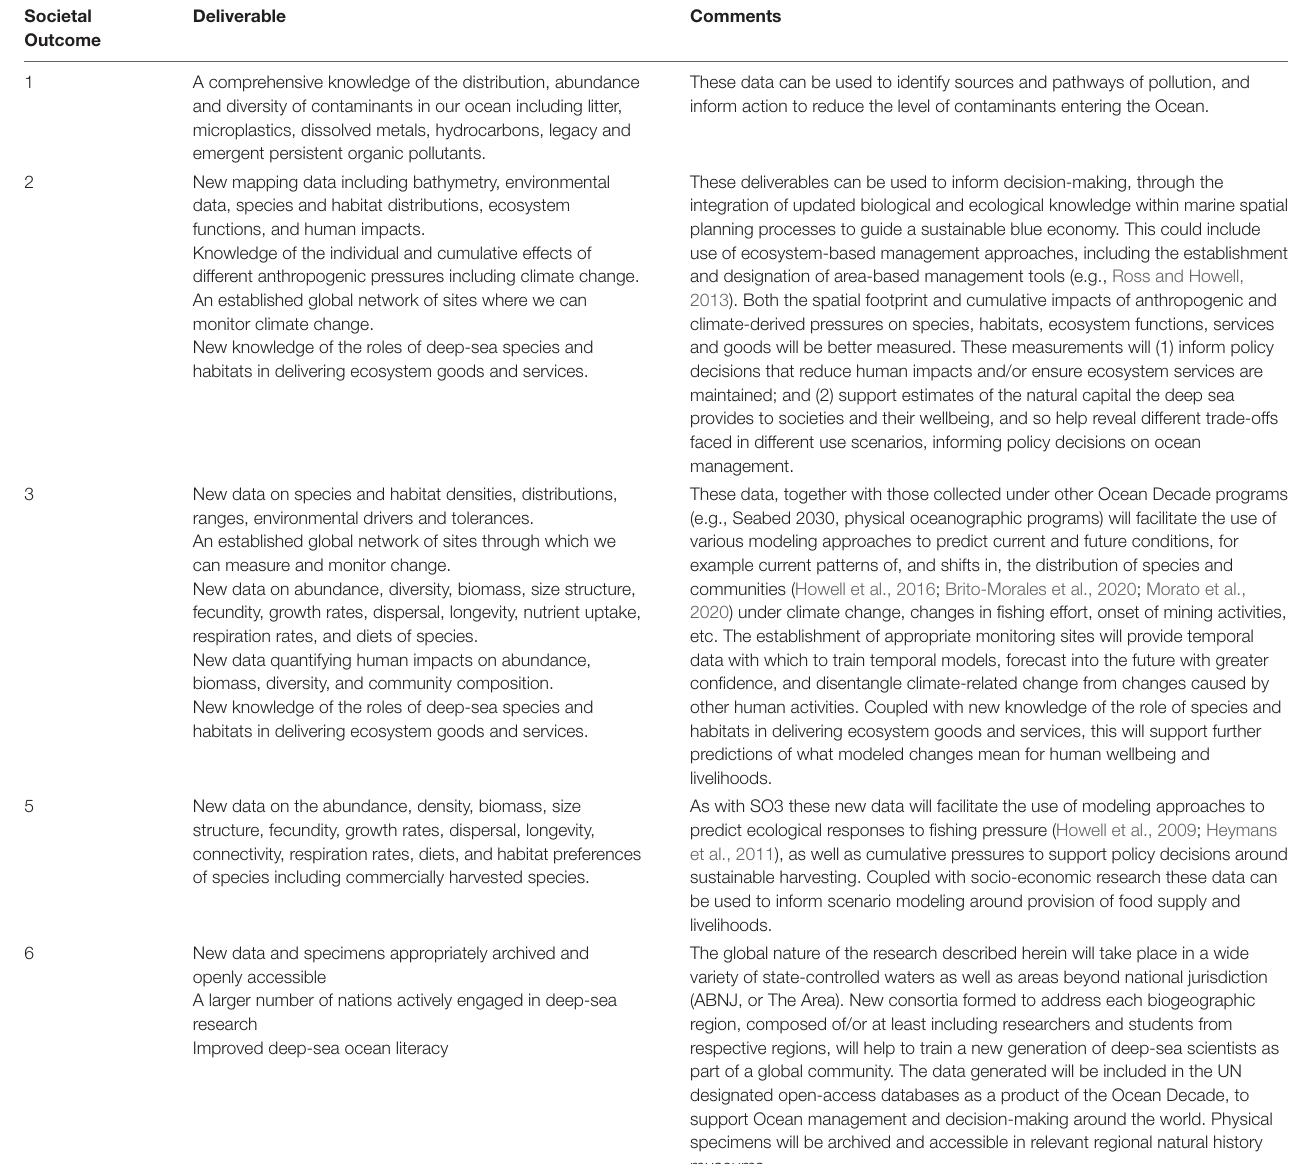
TABLE 3 | What an inclusive global program could deliver against each of the relevant Ocean Decade societal outcomes and by inference SDG14. Societal Outcome